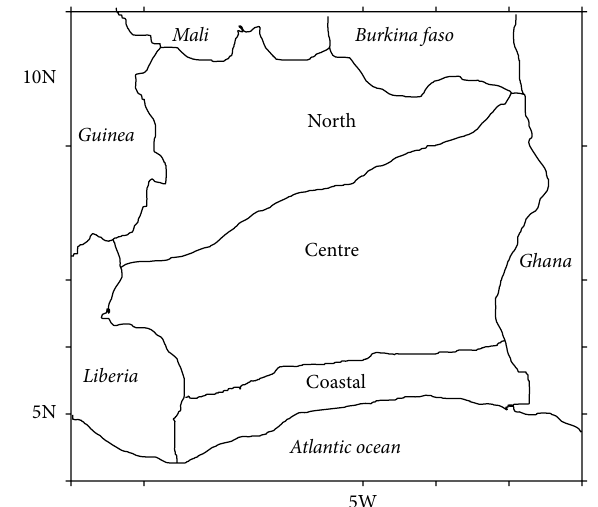
Figure 1: Map of Côte d’Ivoire including the climatic zones (adapted from [34,